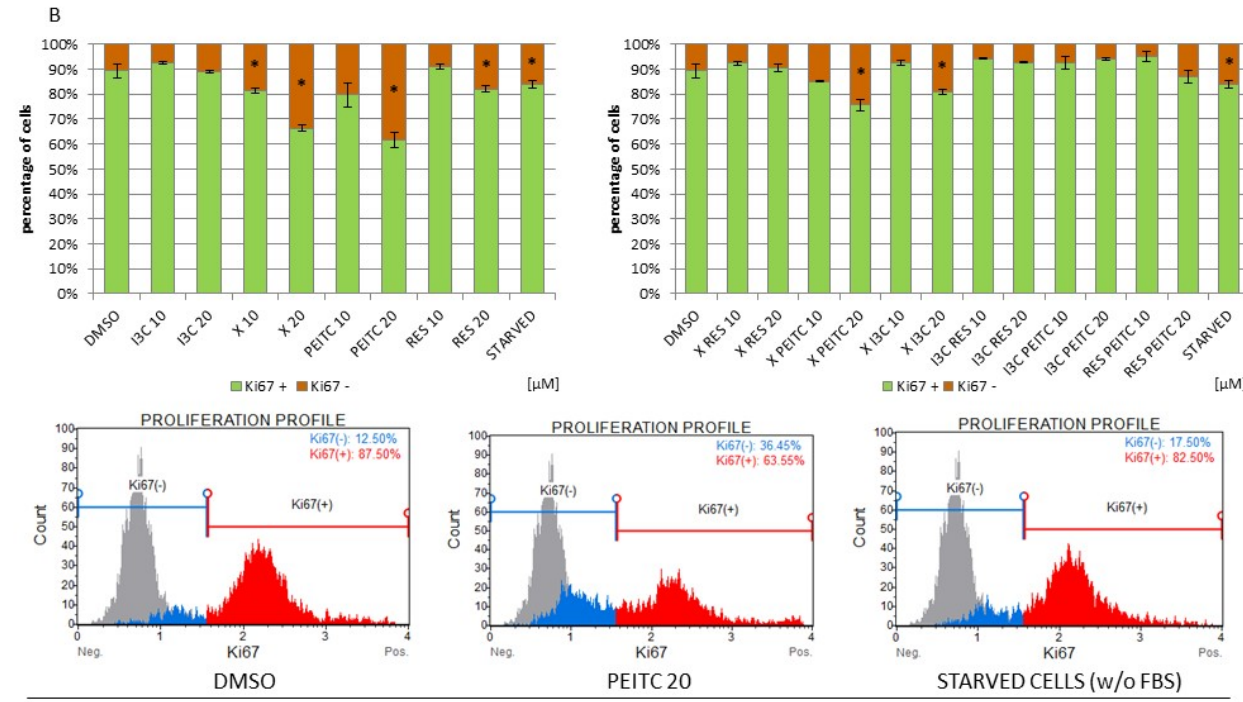
Figure 12. The impact of X, PEITC, RES, I3C, and their mixtures on the ROS production and on cell proliferation in HepG2 cells. Panel ( A ) The percentage of reactive oxygen species negative (ROS ( − ); M1) and positive (ROS (+); M2) cells based on dihydroethidium reaction with superoxide. The fluorescent signal was analyzed by flow cytometry. Exemplary plots are presented on the right side. Panel ( B ) The percentage of proliferating (Ki67 (+)) and non-proliferating (Ki67 ( − )) cells were analyzed by flow cytometry. Starved cells (cultured without FBS) were acted as a reference to antiproliferative conditions. Exemplary plots are presented. Results were calculated from three separate experiments (mean ± SEM). (*) above the bar indicates statistically significant differences from the control group, p < 0.05.